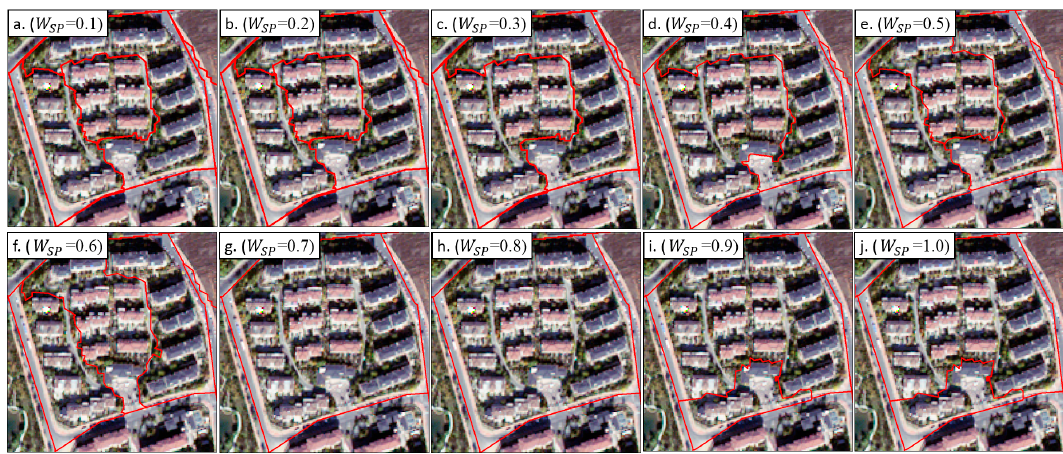
Figure 13. Ten segmentation results for a residential district using different weights of spatial-pattern features (0.1, 0.2, . . . ,1), at the scale of 130. W SP denotes the weight of spatial-pattern features, and the red lines represents the segmented boundaries.